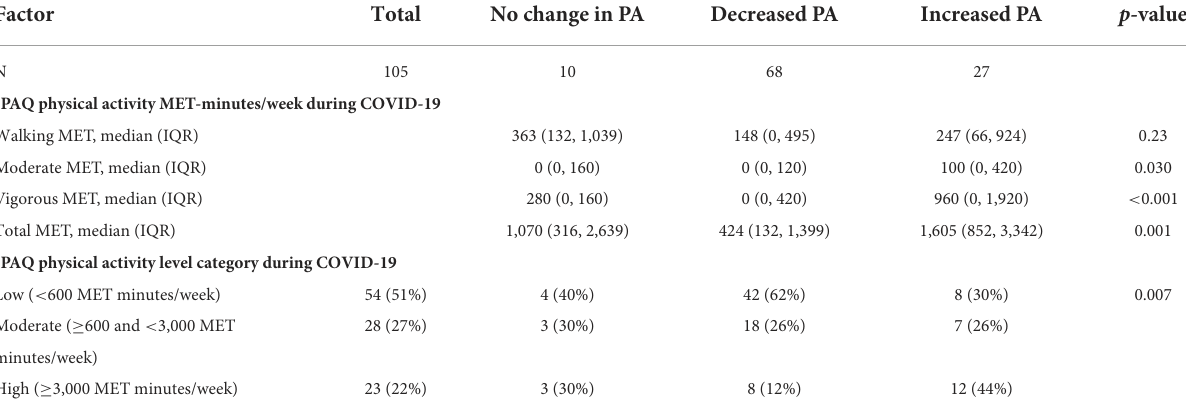
TABLE 3 IPAQ physical activity data during COVID-19 social distancing measures according to change in physical activity (PA) levels # .